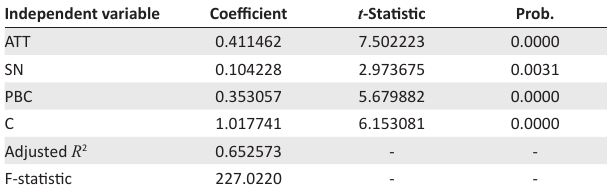
TABLE 7: Model 2 – Regression analysis with Bartlett-Kernel, Newey-West adjustments for heteroskedasticity (Dependent Variable: